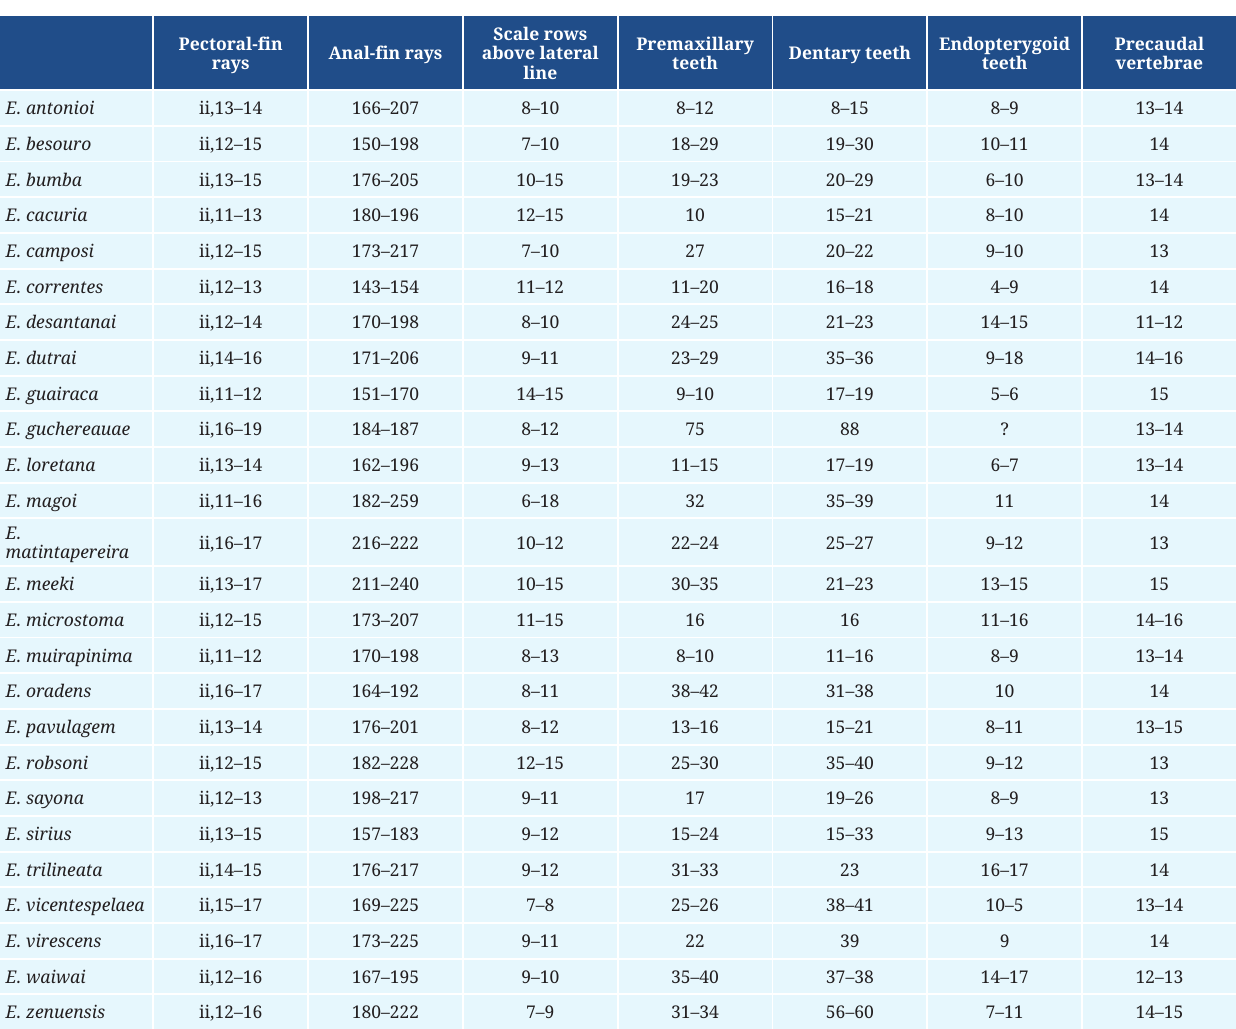
TABLE 3 | Summary of meristic diagnostic characters for the 26 recognized species of the Eigenmannia trilineata species-group. Table redrawn and modified from Waltz, Albert (2018) based on compiled data from Peixoto et al . (2015), Peixoto, Wosiacki (2016), Campos-da-Paz, Queiroz (2017), Dutra et al . (2017, 2018, 2021), Peixoto, Waltz (2017), Peixoto, Ohara (2019), Herrera-Collazos et al. (2020), and Peixoto et al.